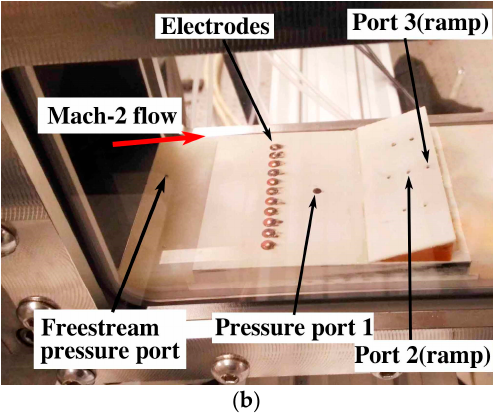
Figure 3. Compression ramp model: ( a ) Test arrangement and compression ramp geometry; ( b ) photograph of the model ramp in the test section.